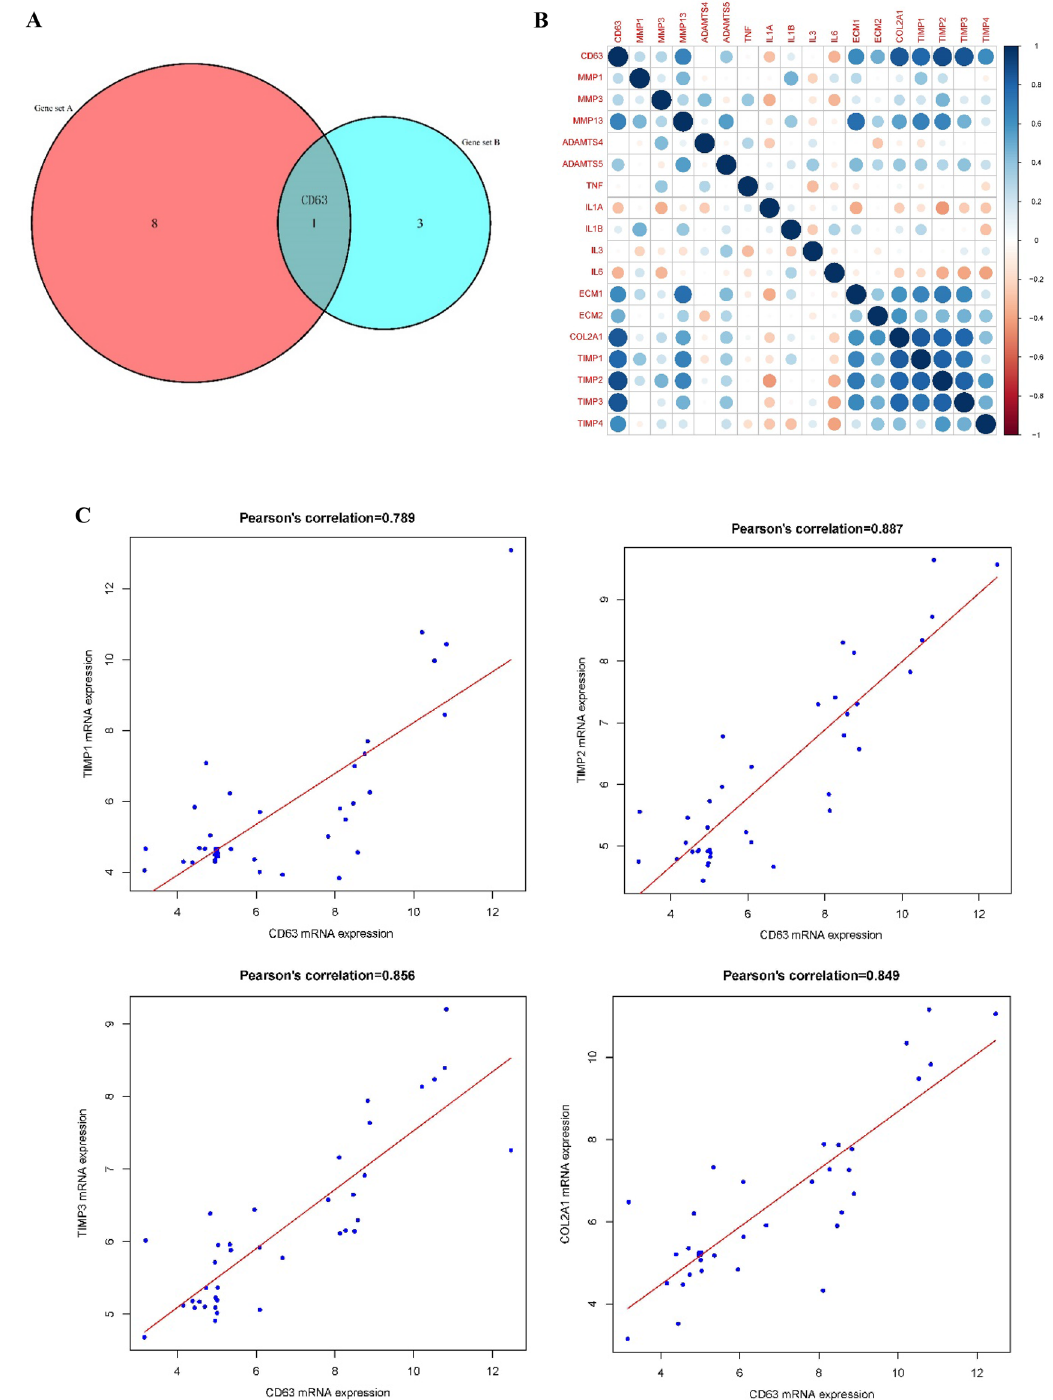
Figure 4. Selection of target genes. ( A ) The genes that closely related to intervertebral disc degeneration screened in weighted correlation network analysis (Gene set A) and co-expression network (Gene set B). ( B ) Pearson correlation analysis between CD63 and IL1, ECM, COL2A1, TIMP, MMP and ADAMTS. ( C ) Significant relatedness of CD63 with TIMP1, TIMP2, TIMP3 and